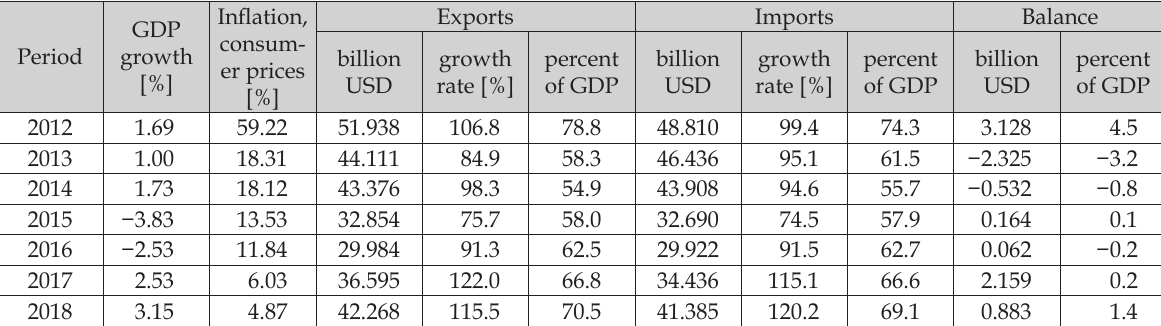
Table 1. Dynamics of exports and imports of the Republic of